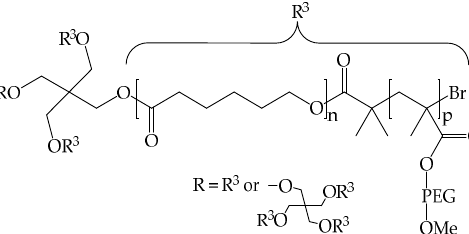
Figure 5. Amphiphilic multi‐arm star‐shaped block copolymers based on a poly(ε‐caprolactone) core and a pegylated comb‐like shell. Reproduced with permission from reference [30], Royal Society of Chemistry, 2009.